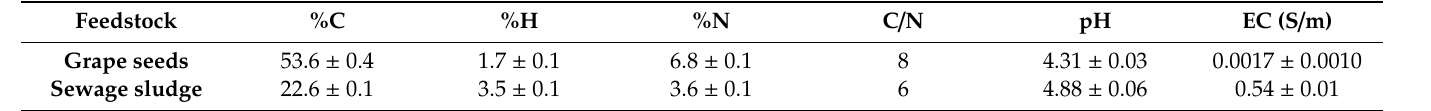
Table 1. Characterization of the initial feedstocks (averaged value ± standard error; n = 3).